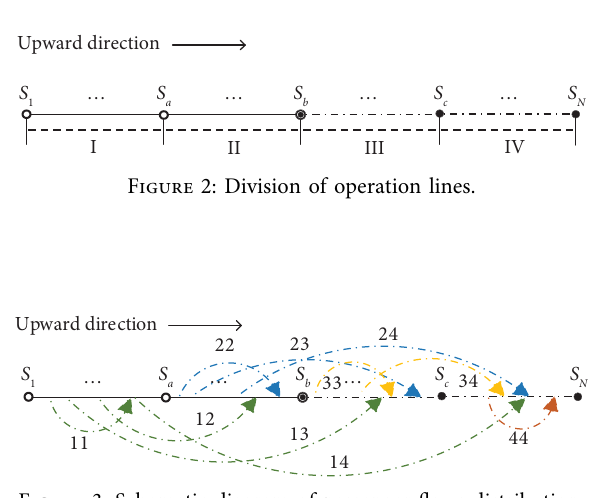
Figure 3: Schematic diagram of passenger flows